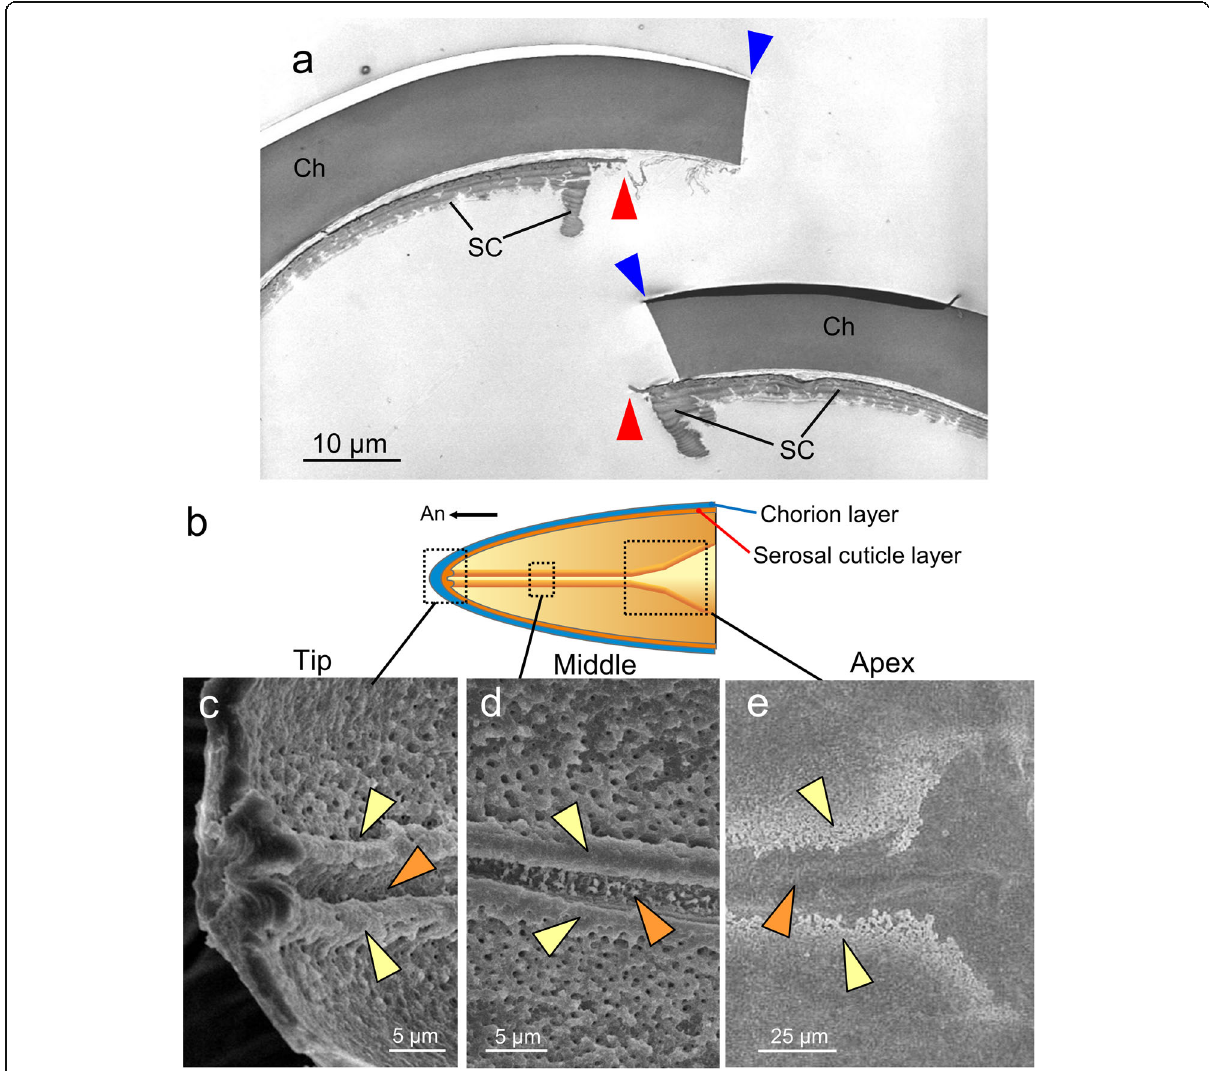
Fig. 3 The hatching line in the serosal cuticle. a A TEM image of the anterodorsal cleavage site of a hatched eggshell. Blue and red arrowheads indicate the cleavage sites in the chorion and serosal cuticle, respectively. b A schematic representation of the inner surface structure of the anterodorsal part of the eggshell. c-e Interior SEM images of the eggshell of the fully developed eggs at the represented sites shown in ( b ). A furrow (orange arrowheads) flanked by two ridges (yellow arrowheads) runs along the midline of the anterior part. Abbreviations: Ch, chorion; SC, serosal